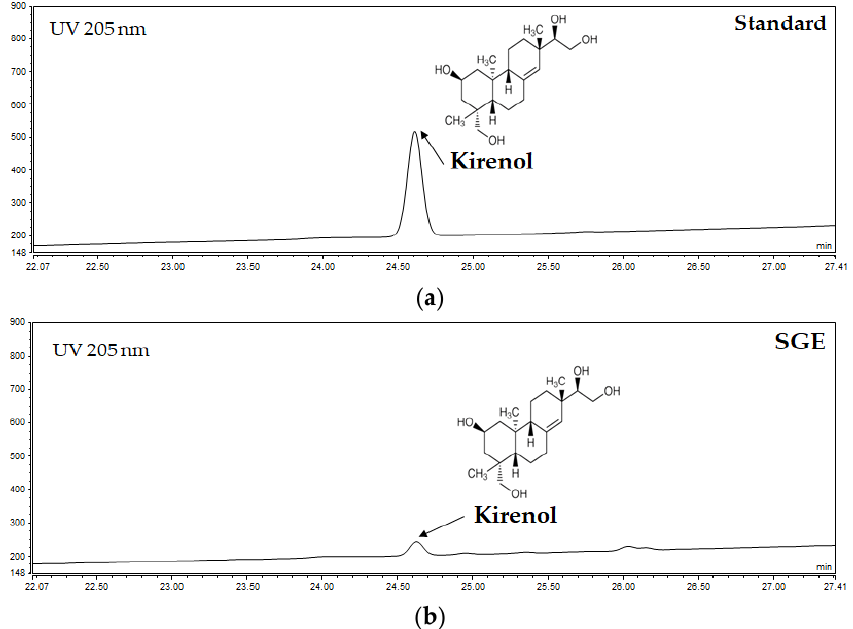
Figure 1. RP-HPLC analysis of kirenol standard ( a ) and SGE ( b ).